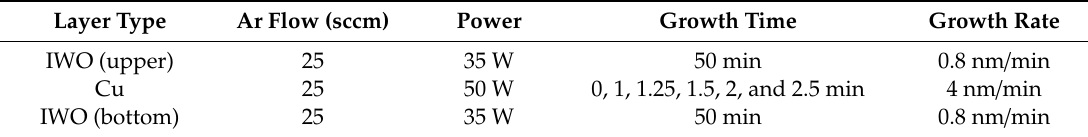
Table 1. Sputtering parameters for IWO and Cu